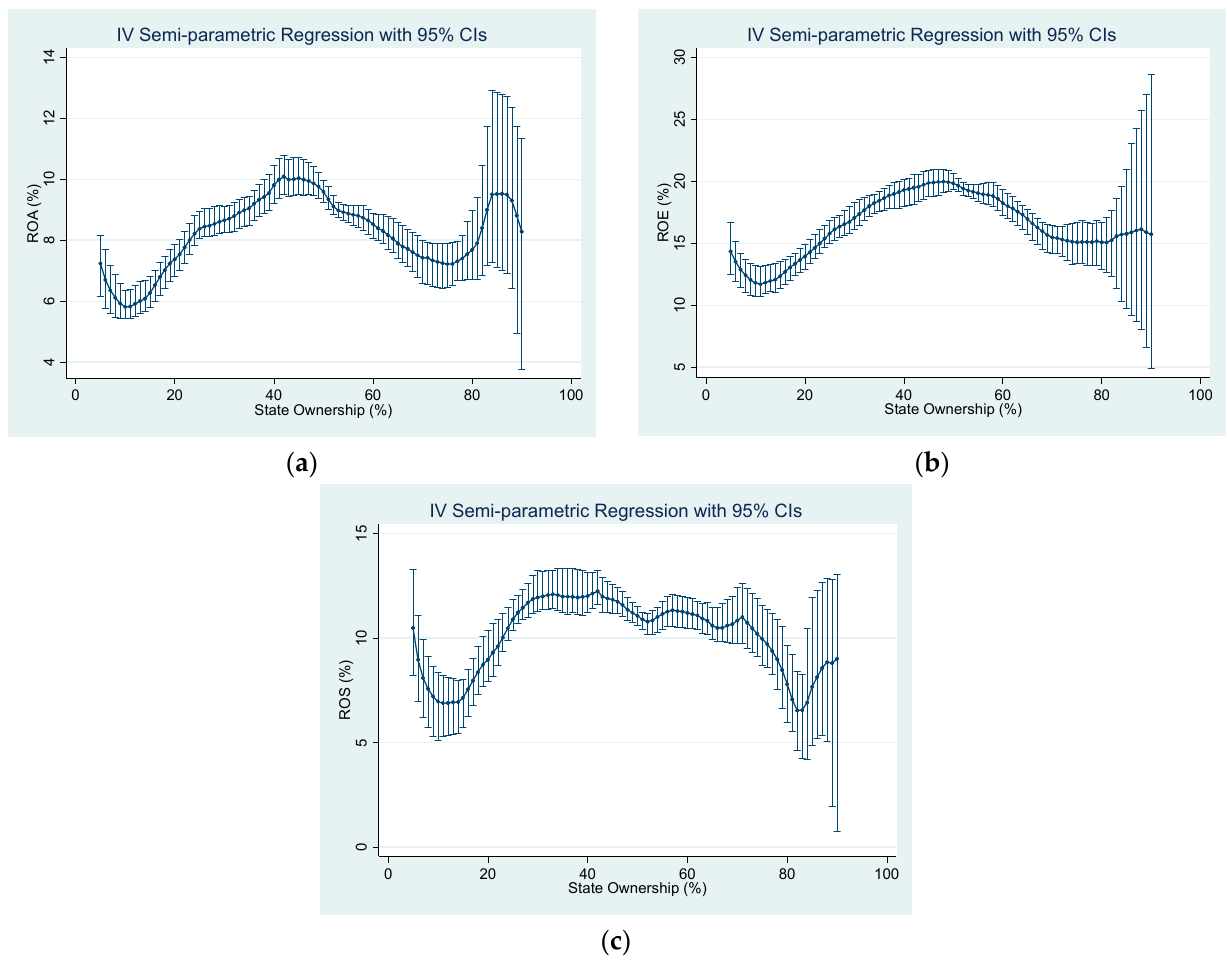
Figure 3. Semiparametric IV estimates of firm’s ROA ( a ), ROE ( b ), and ROS ( c ) on state ownership. This figure presents the marginal effect of state ownership on partially privatized firm’s ROA (%), ROE (%), and ROS (%). The continuous lines correspond to the estimates, whereas the capped spikes correspond to the 95% confidence intervals.